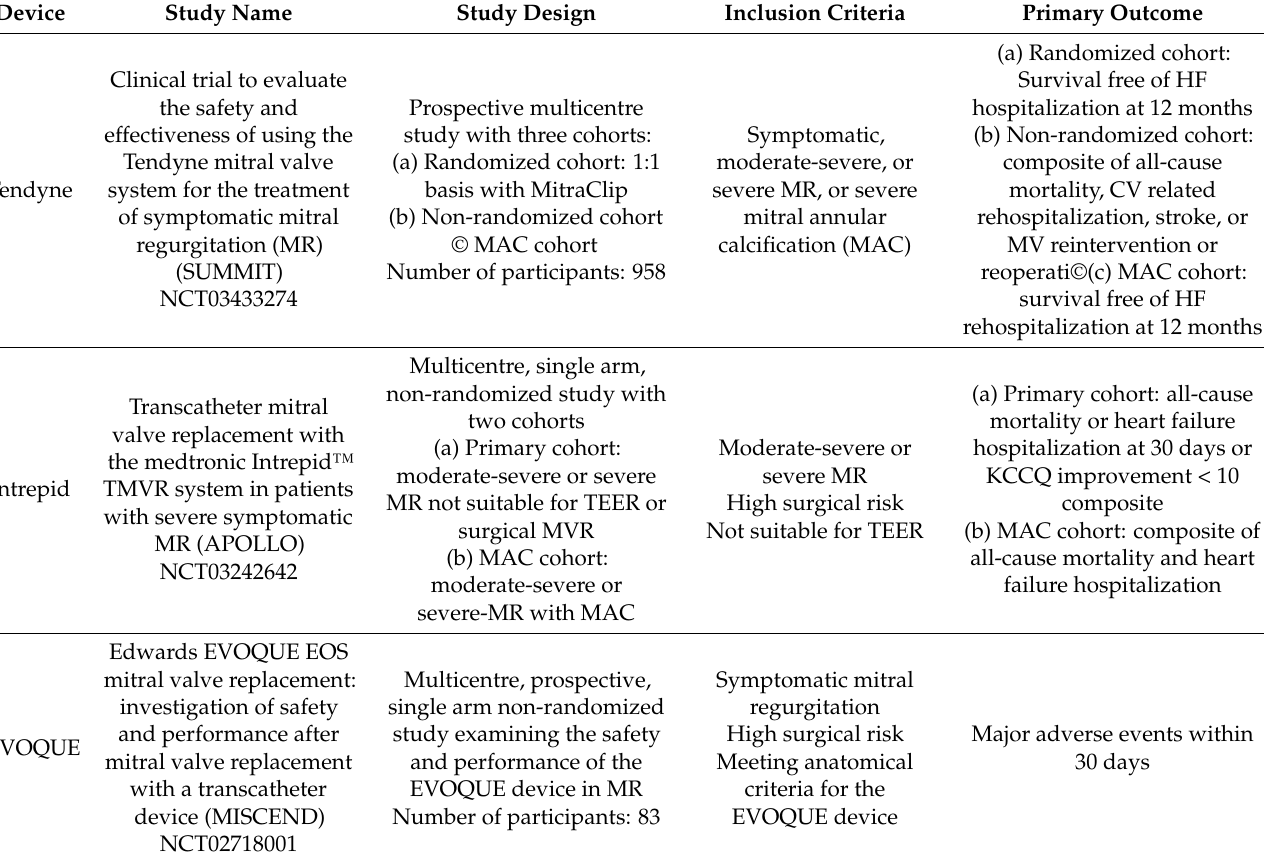
Table 5. Upcoming studies in transcatheter mitral valve replacement (TMVR)